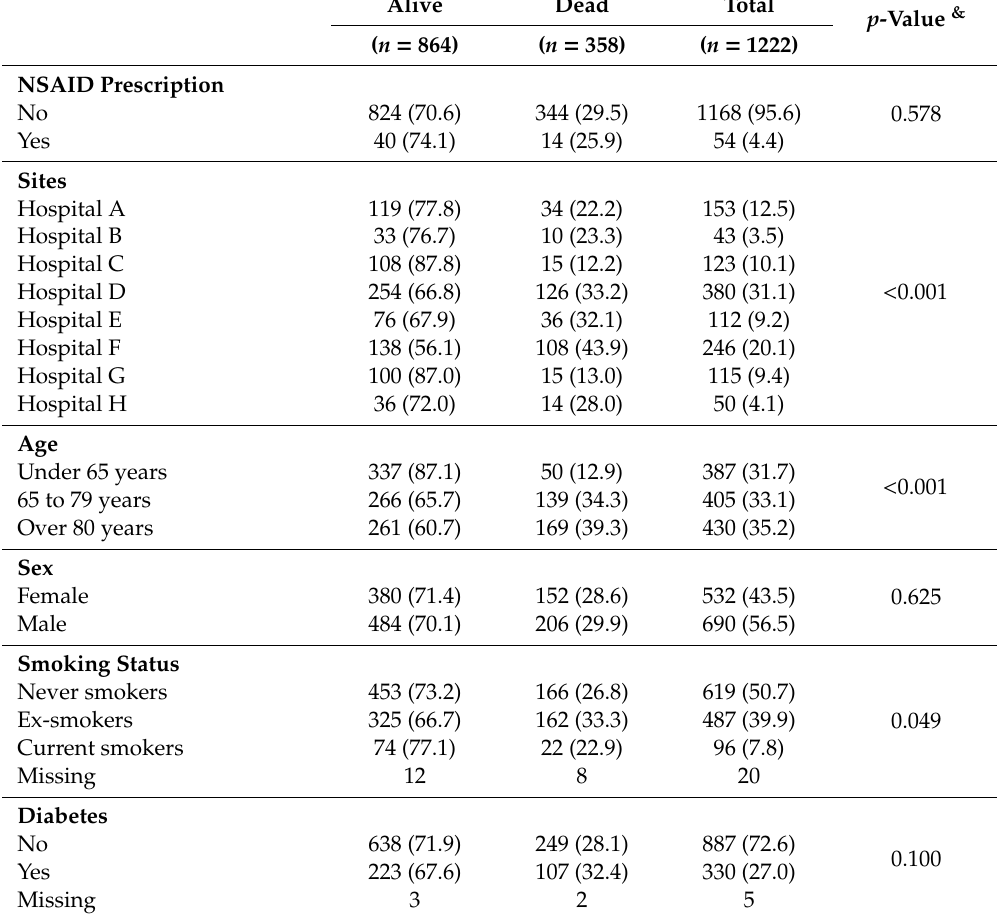
Table 1. Demographics, comorbidities and non-steroidal inflammatory drugs (NSAID) usage by in hospital mortality. Alive